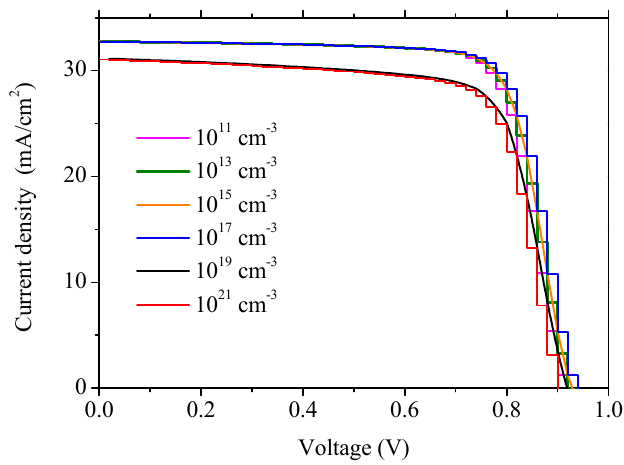
Figure 11. Effect of IL2 defect density on J-V characteristics.